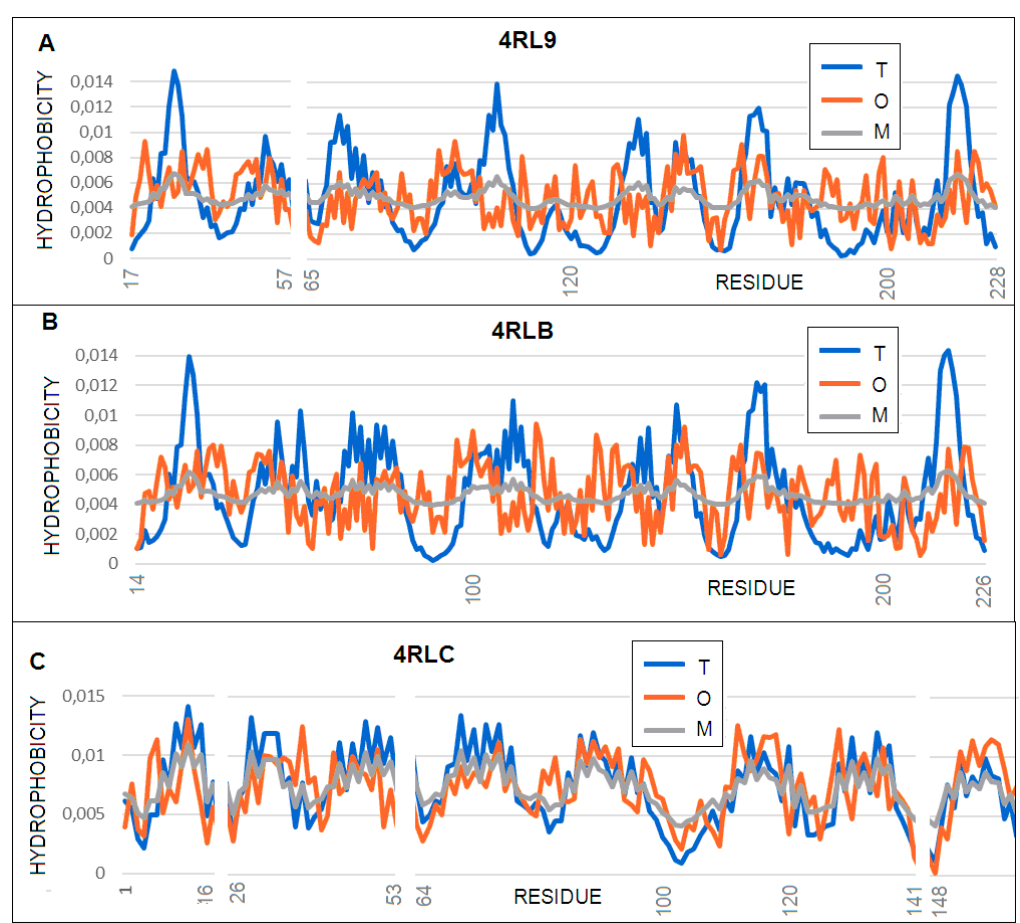
Figure 8. Profiles: T (blue), O (red), and M (gray) for: ( A ) 4RL9, profile M for K = 1.2; ( B ) 4RLB, profile M for K = 1.3; and ( C ) 4RLC, profile M for K = 0.3.